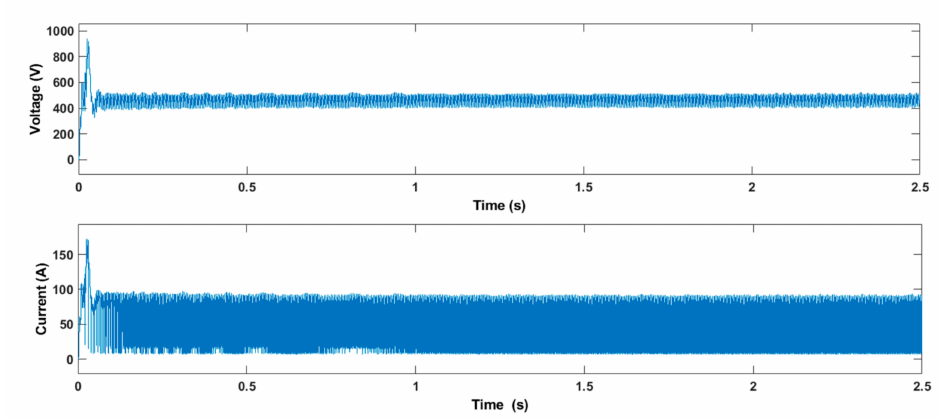
Figure 14. Boost Converter Output Voltage and Current using FLC.